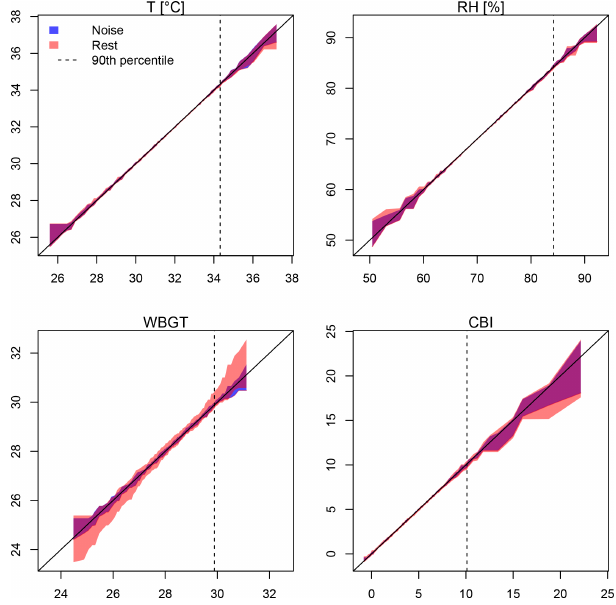
Figure 7. Illustration of the perfect model approach to study the ef- fect of internal variability and UQM on the uncertainty range across models. Shown is the grid point of Austin, Texas, US. UQM was separately applied to temperature ( T ) and relative humidity (RH), using multiple runs (five) of CanESM as observations. CanESM runs bias-adjusted against themselves represent the noise associ- ated with internal variability (blue). The full range represents the range of all model simulations bias-adjusted against all CanESM runs